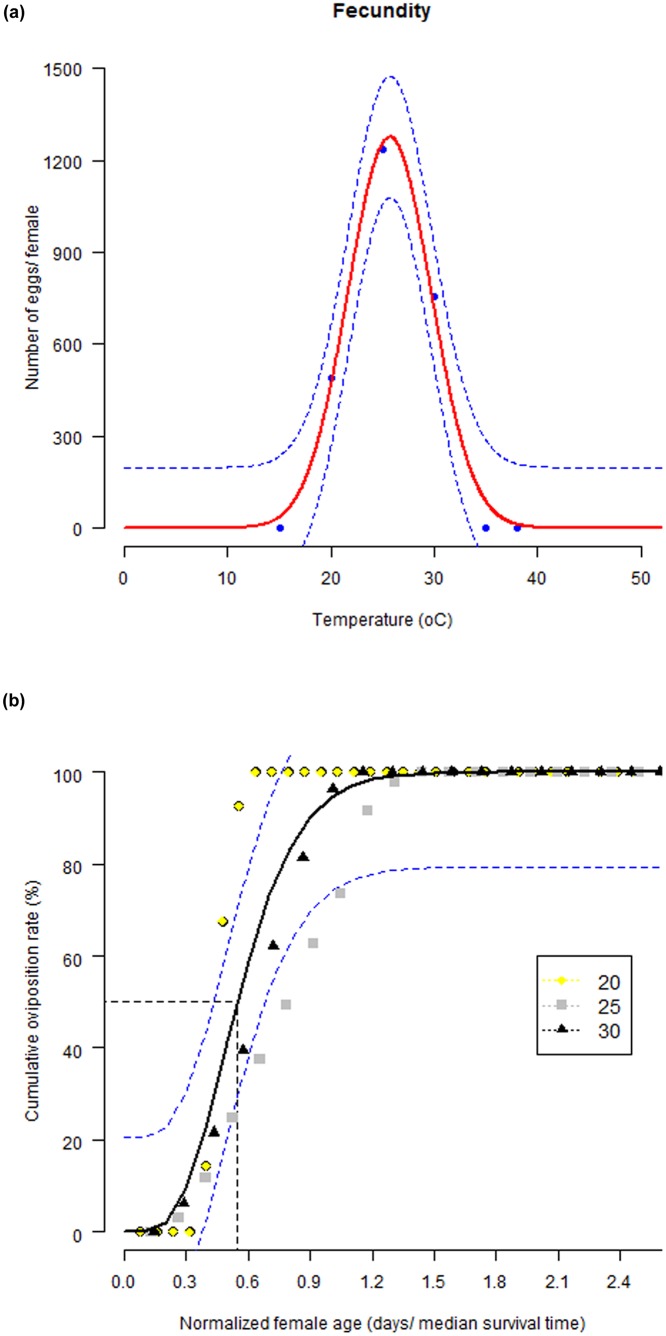
Temperature-dependent reproduction of S. litura.Total egg production curve, fitted function: exponential polynomial model (a); and Age-related oviposition rate, fitted curve: Gamma distribution function (b). The upper and lower 95% confidence intervals of the model are indicated. The dots are observed data points.